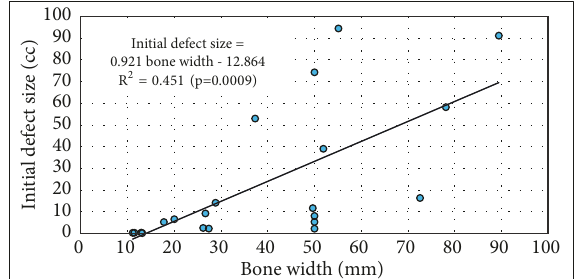
Figure 6: New bone fraction (NB/DV) was inversely proportional to bone